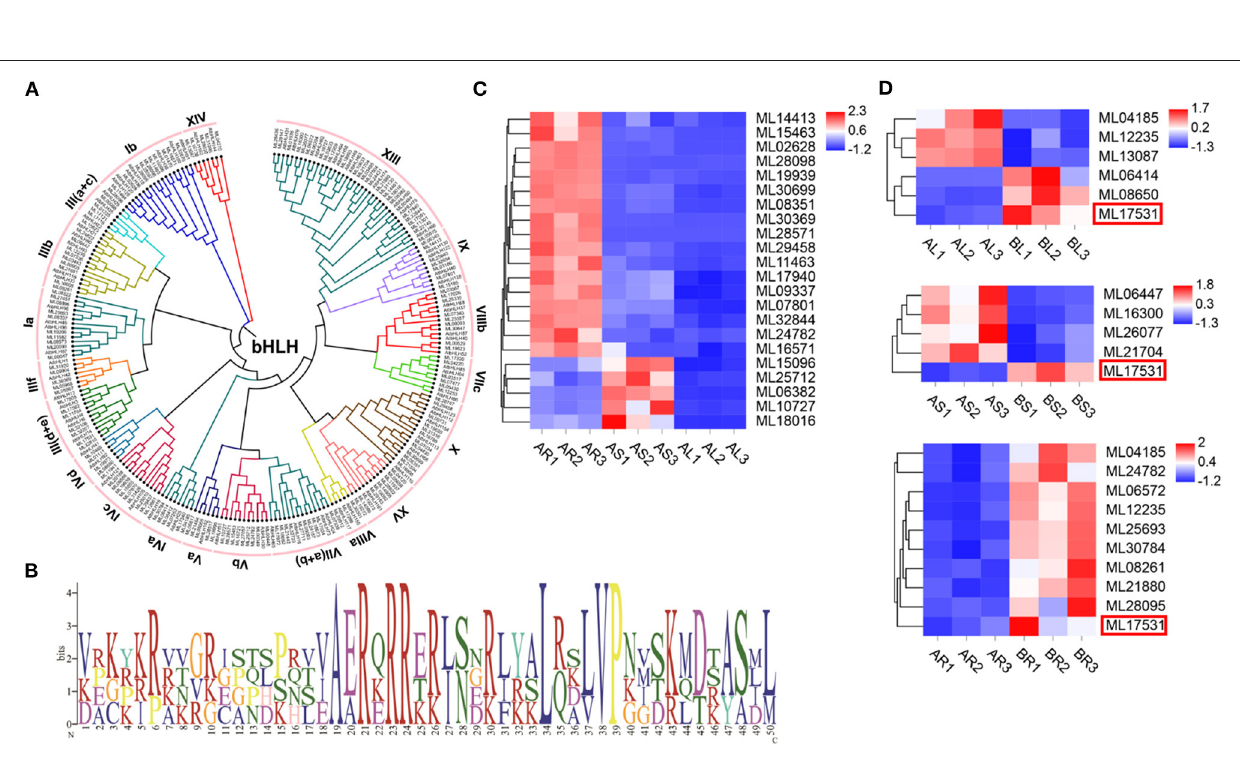
Frontiers in Plant Science |